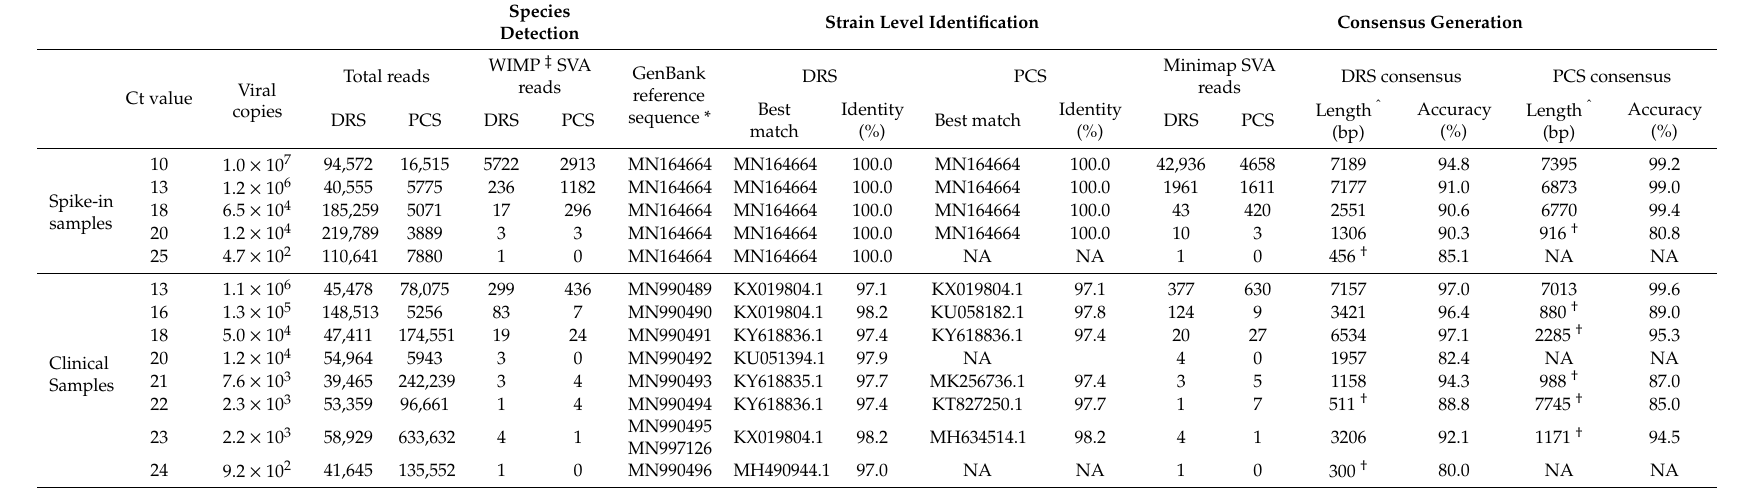
Table 4. Analytical sensitivity of direct RNA sequencing (DRS) and PCR-cDNA sequencing